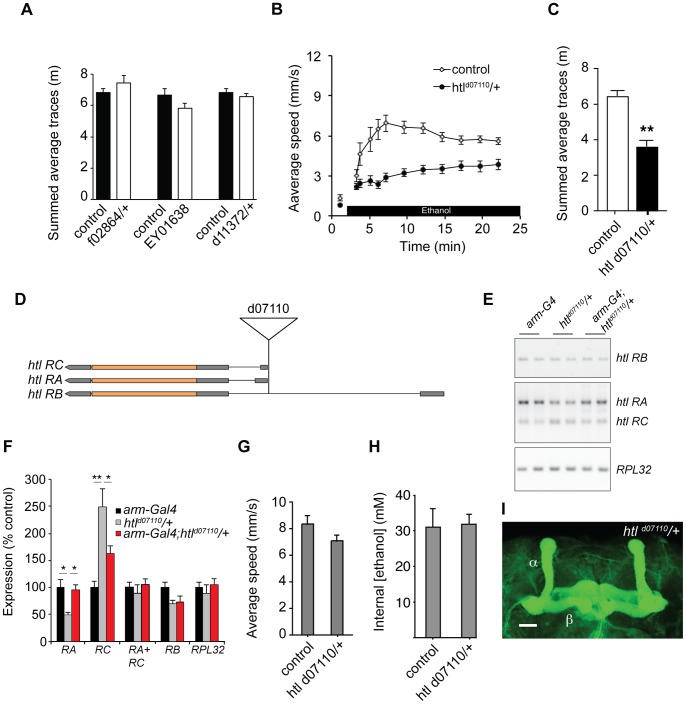
A mutation in the FGFR gene htl reduces ethanol-induced locomotion.(A) Area-under-curve quantification of ethanol-induced locomotion for three lines with P-element insertions in the FGFR gene btl (f0286/+, EY01638, d11372/+) versus controls. (B) Ethanol-induced locomotion assay for htld07110/+, compared to controls. (C) Area-under-curve quantification of (B) **p<0.01 Student’s T-test. (D) Schematic of the transcripts produced by the htl gene, adapted from Flybase (flybase.org). The locus produces three transcripts, RA, RB and RC. The d07110 line has an XP element inserted upstream of the start site for the RA and RC isoforms. (E) RT-PCR of htl transcripts. Total RNA was isolated from heads of armadillo-Gal4 (arm-Gal4), htld07110/+ and arm-Gal4; htld07110/+ flies. RT-PCR was performed with primers amplifying the RB transcript, or the RA and RC transcripts, and primers for a housekeeping gene control (RPL32). (F) Quantification of RT-PCR experiments. Levels of htl RA, RB and RC transcripts, and the combined level of RA and RC expression (RA+RC) as percent of expression in the armadillo-Gal4 control line. Error bars represent SEM. *p<0.05, **p<0.01, One-way ANOVA with Neuman-Keuls post-hoc test. n = 3. (G) Peak locomotion during ethanol-induced olfactory startle for mutant and control strains. (H) Ethanol absorption after 20 minutes for htld07110/+ flies compared to wild-type controls. (I) Anti-Fas II staining of wholemount brain from htld07110/+. Scale bar = 10 µM.